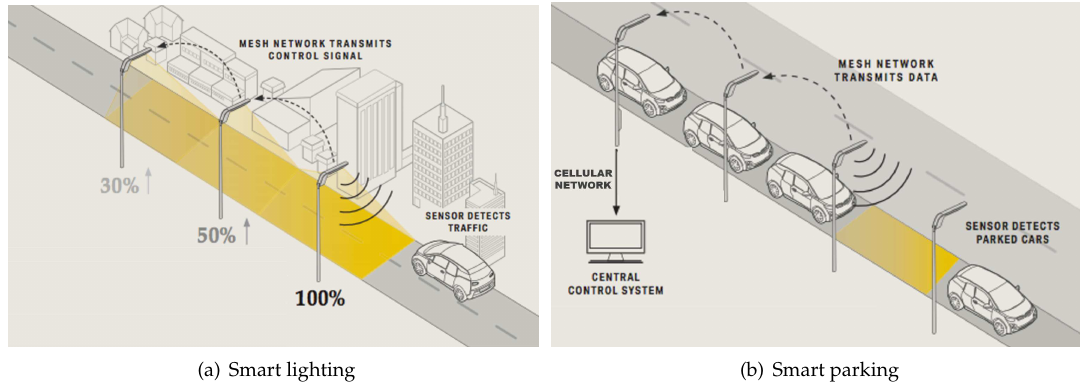
Figure 1. Examples of smart services enabled by intelligent street lamps.